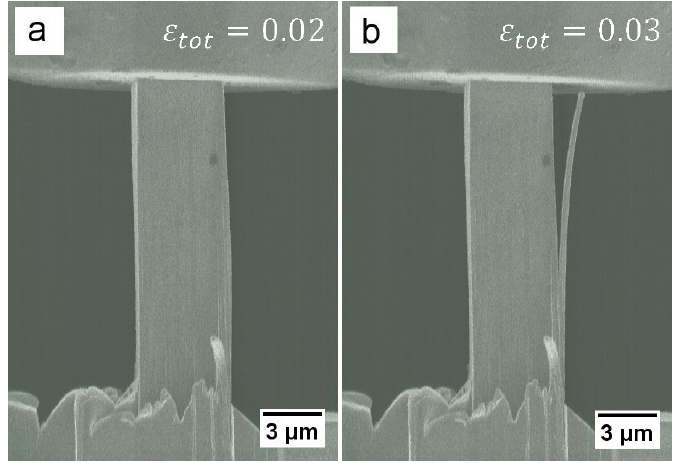
Figure 3. In-situ SEM images of sample 1 during elastic loading ( a ) before and ( b ) after detachment of an FIB induced re-deposition